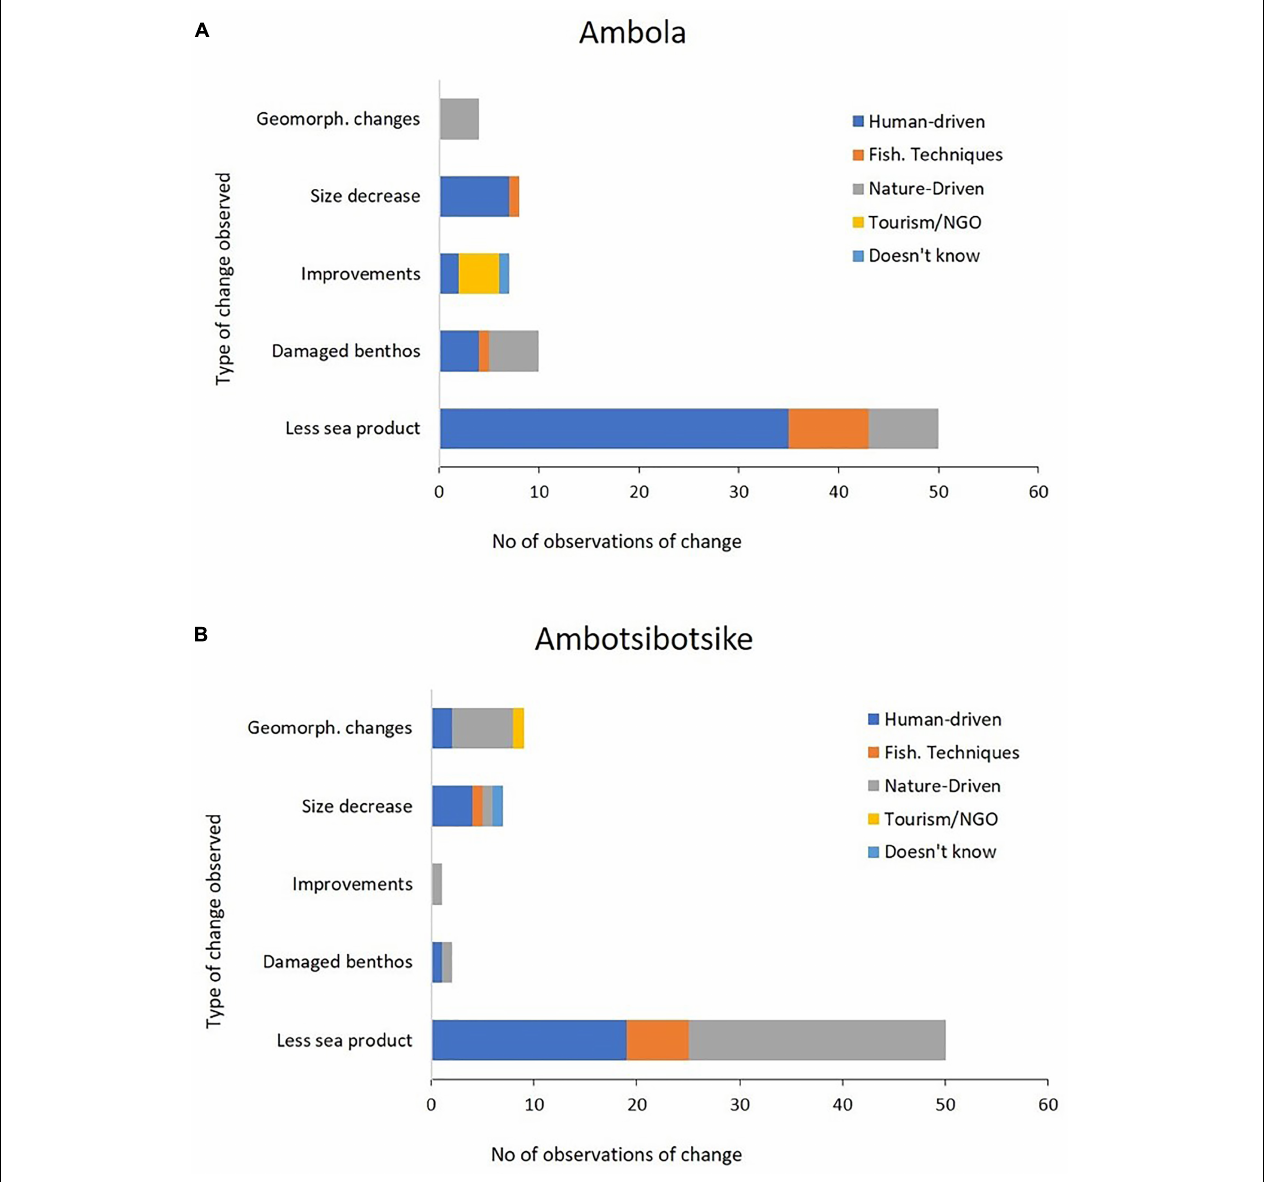
FIGURE 4 | Types of changes against the origin of changes in (A) Ambola ( n = 79) and (B) Ambotsibotsike ( n = 69) in the sea environment as determined through interviews with community